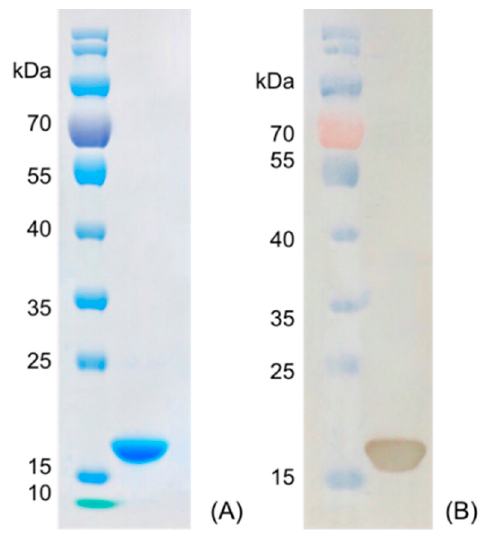
Figure 3. Characterization of nanobody Nb316 by SDS-PAGE and Western blotting. ( A ) SDS-PAGE: marker and purified Nb316. ( B ) Western blotting: marker and purified Nb316.